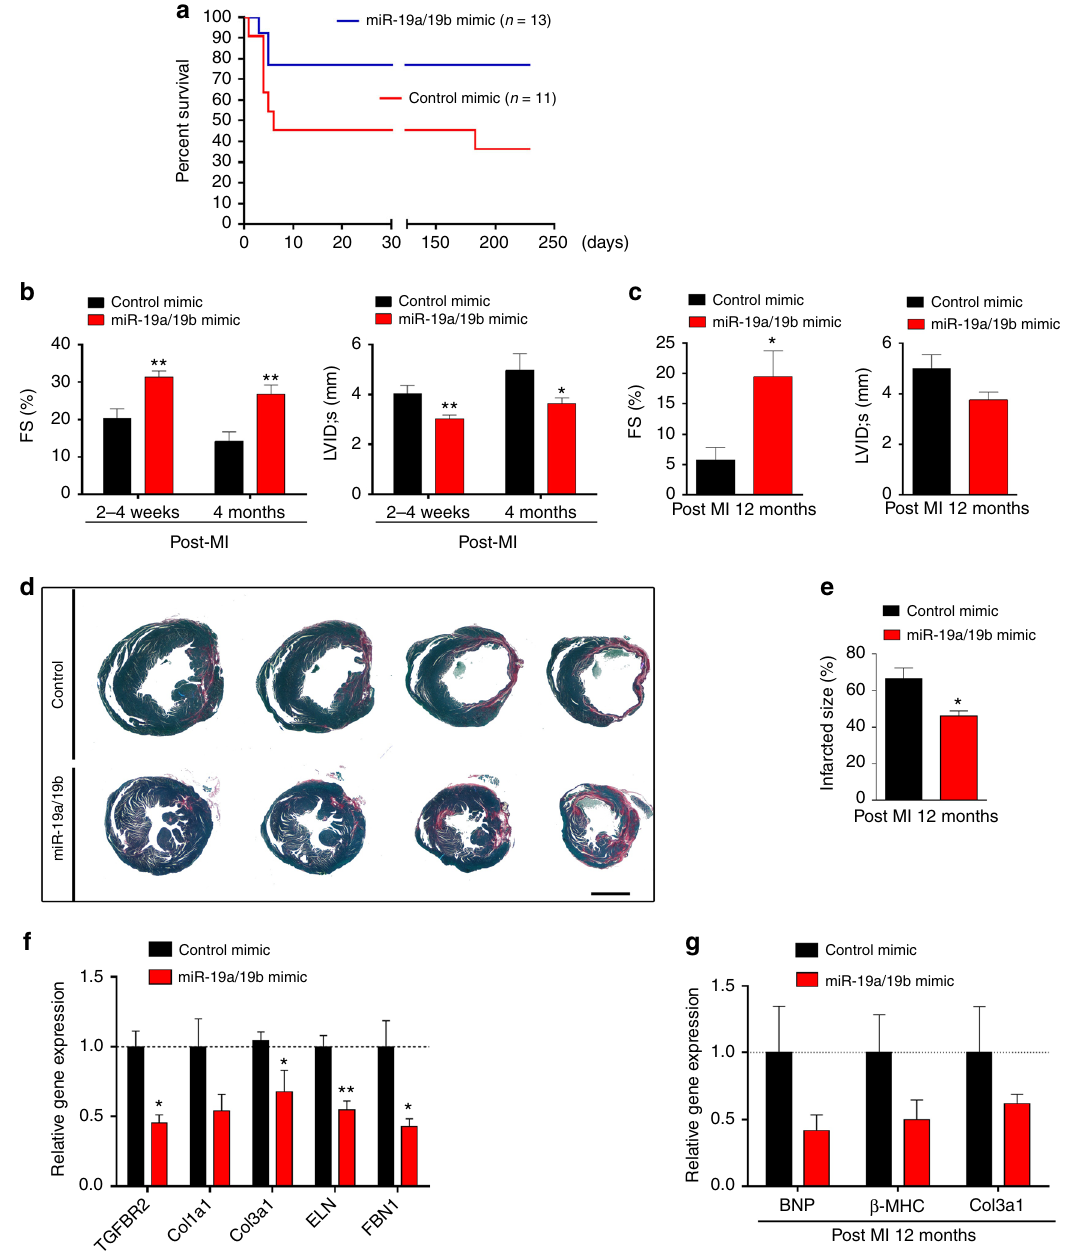
Fig. 3 Short-term and long-term cardiac protection after myocardial infarction and injection of miR-19a/19b mimics. a Kaplan – Meier survival curves after injection of miR-19a/19b mimics compared to injection of control mimic after MI injury. n = 11 mice mimic control; n = 13 mice, miR-19a/19b mimics. b , c Echocardiography analyses of cardiac function after miR-19a/19b mimic injection at both short term of 2 – 4 weeks and 4 months ( b ) and long term of 12 months ( c ) after MI injury compared to their control group. FS% left ventricular fractional shortening. LVIDs LV internal dimension at end-systole. n = 3 – 12 mice. d Representative images of series of transverse sections after injection of miR-19a/19b mimics compared to control mimic at long term of 12 months after MI injury. Sirius red/fast green collagen staining marks myocardium (green) and scar (red). Scale bar = 2 mm. e Quanti fi cation of the size of scar after injection of miR-19a/19b mimics compared to control mice at long term of 12 months after MI injury. n = 3 mice. f qRT-PCR detection of expression of fi brotic remodeling marker genes 4 days after mimic injection and MI injury. n = 3 – 7 mice. g qRT-PCR detection of expression of pathological remodeling marker genes 12 months after mimic injection and MI injury. n = 4 – 6 mice. Statistical signi fi cance was calculated using Student ’ s t -test in b , c , e , f , and g and data are presented as means ± s.e.m. * p < 0.05, ** p < 0.01 vs. control. Source data are provided as a Source Data fi